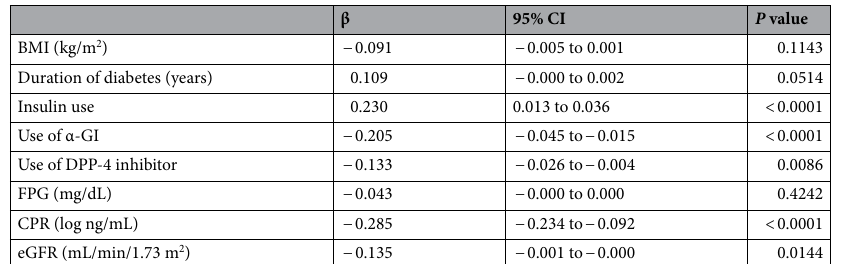
Table 3. Relationships between clinically relevant factors and log-transformed CV, according to multiple regression analysis. β regression coefficient, 95% CI 95% confidence interval, CV coefficient of variation,